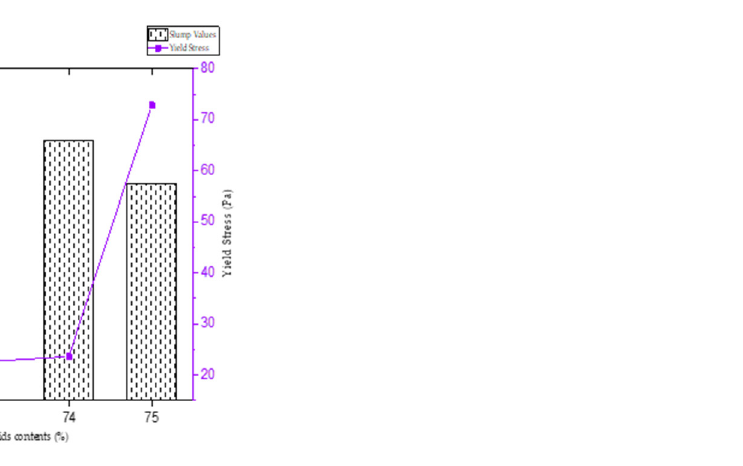
Figure 5. Slump values for different CTB at Cw 72 wt. %, 74 wt. % and 75 wt. % and binder of 1 wt. %.